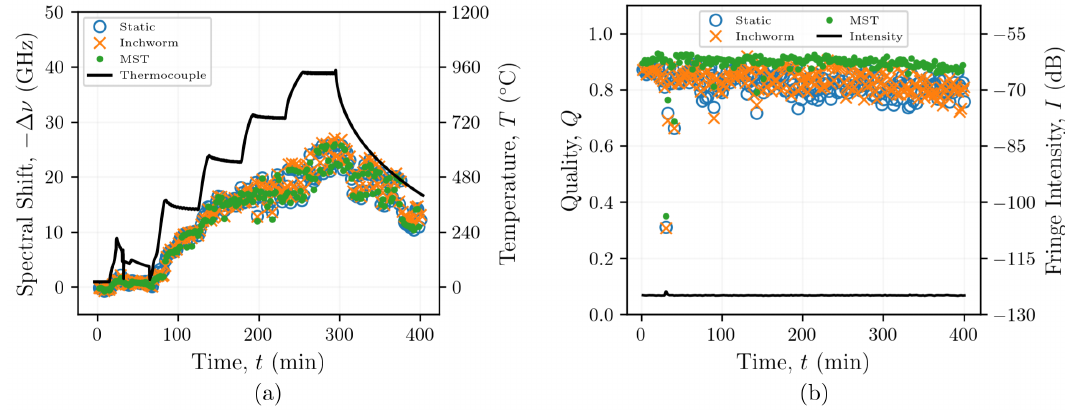
Figure A1. Spectral shifts ( a ) and qualities ( b ) of reconstructions of data from the region of the SMF-28 optical fiber outside of the furnace produced using the static reference, the inchworm algorithm, and MST post-processing methods. The temperatures indicated by the black line are indicative of the furnace temperature at the time of recording and are the cause for the smaller spectral shifts, relative to Figure 5.